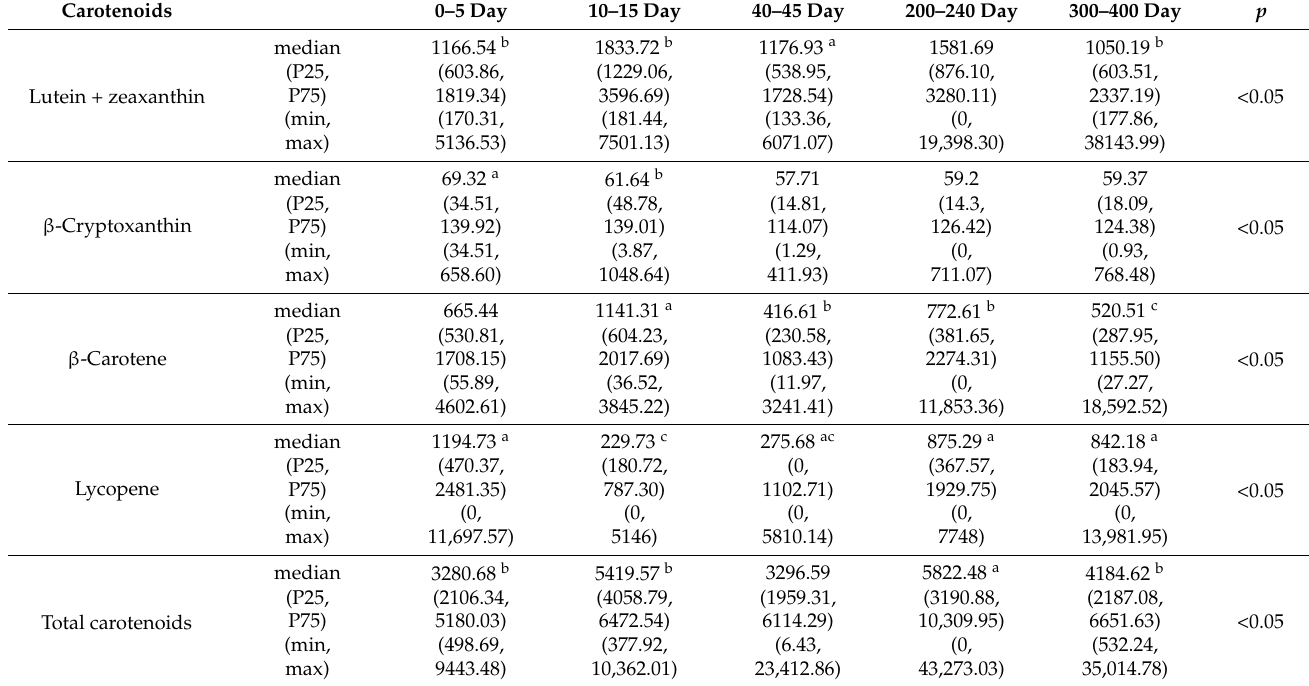
Table 7. The dietary intake and comparison of carotenoids in different stages of lactation ( µ g/L).